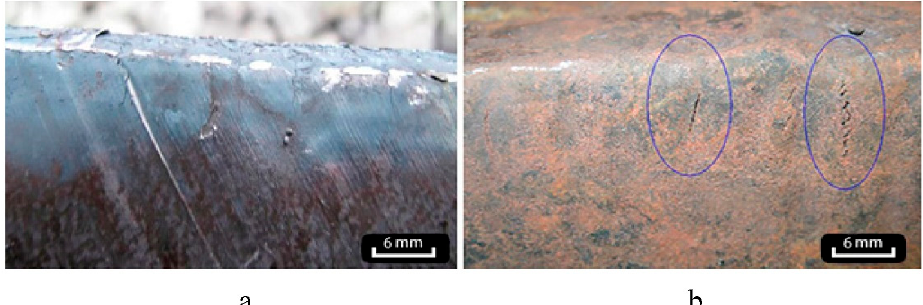
Figure 5. Transverse corner cracks in a typical micro-alloyed steel of a right-angle slab. ( a ) Transverse corner cracks; ( b ) cracks at a distance of 5–15 mm from the corners.